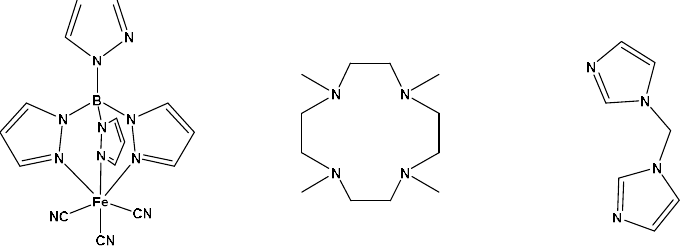
Figure 1. The chemical drawings of the [(pzTp)Fe(CN) 3 ] molecular building block ( left ), 1,4,7,10-tetramethyl-1,4,7,10-tetraazacyclododecane ( middle ), and the bis(1-imidazolyl)methane ( right ) used in this